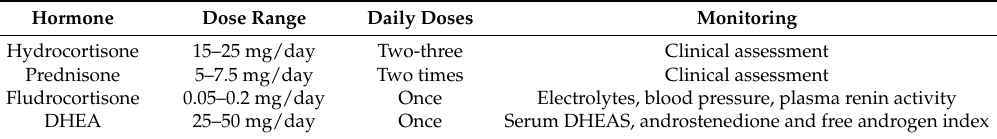
Table 2. Chronic hormone replacement in adrenal insufficiency in